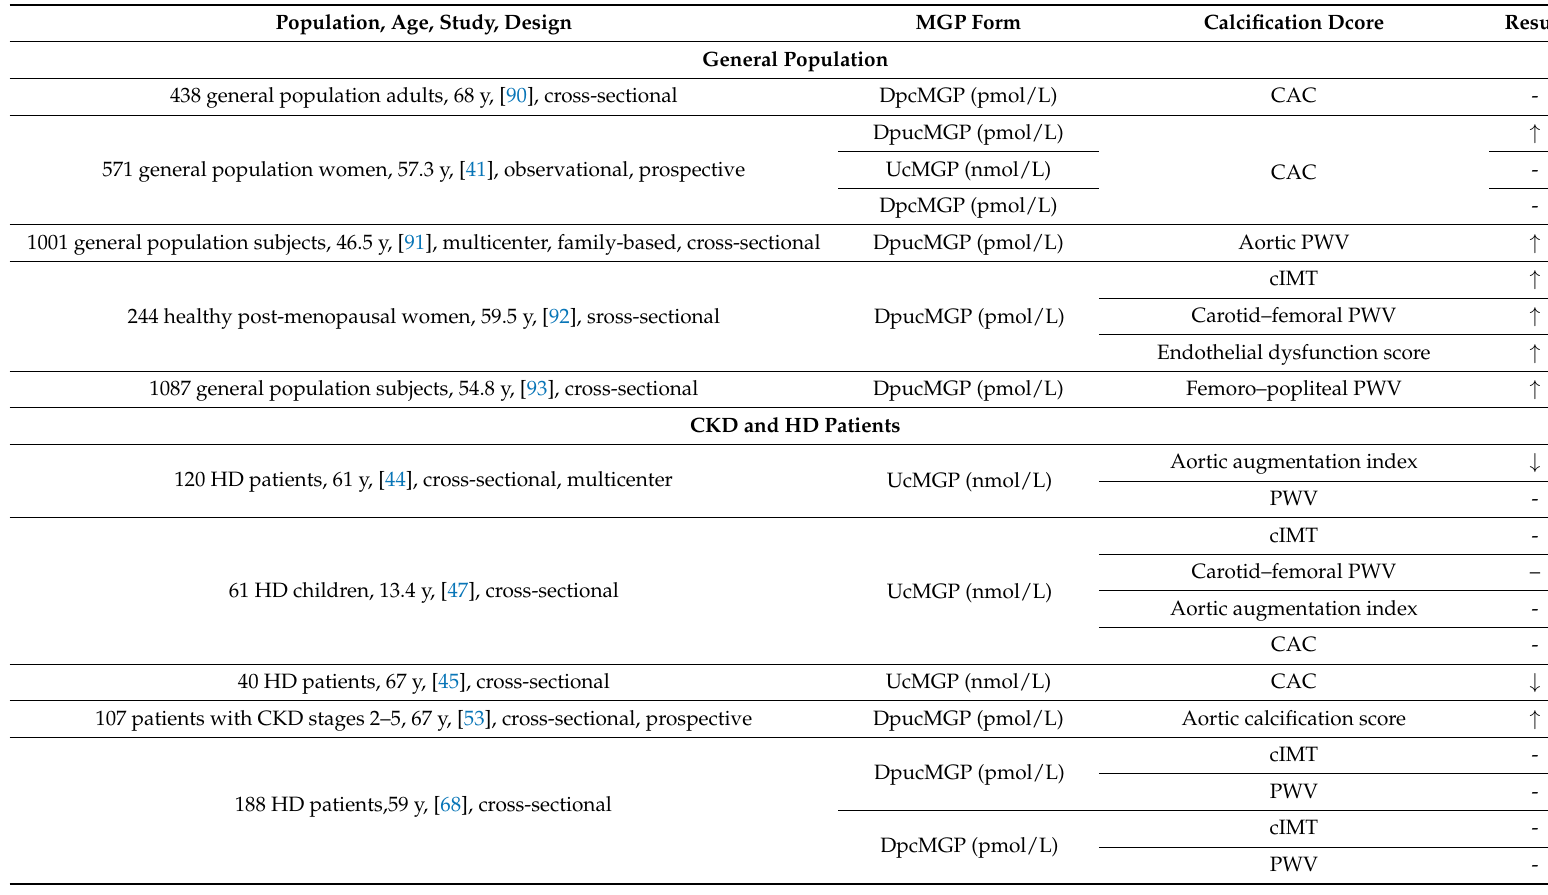
Table 1. Overview of associations between circulating levels of MGP forms and aortic stiffness/arterial calcification scores. Population, Age, Study, Design MGP Form Calcification Dcore Result General